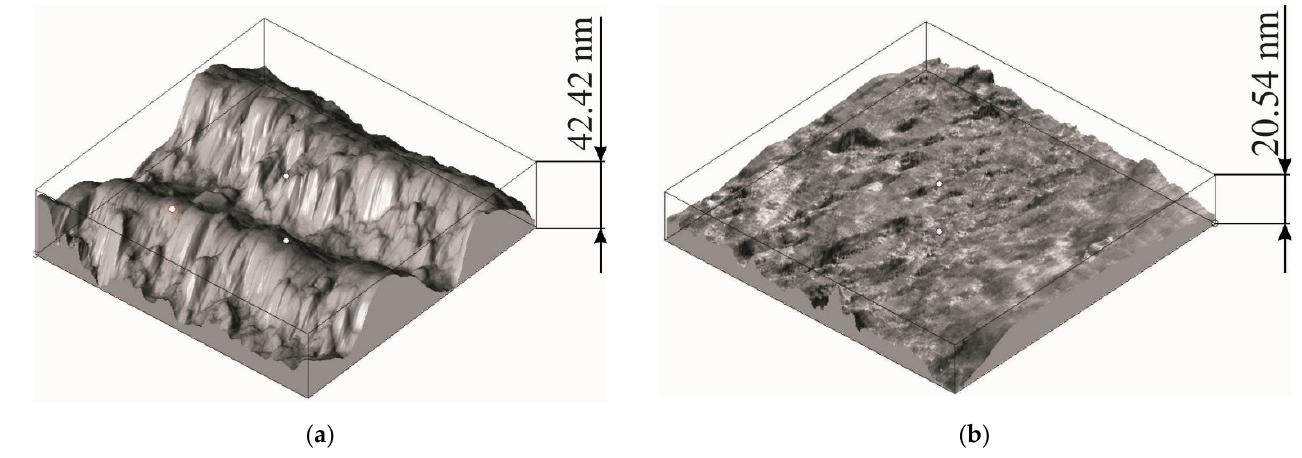
Figure 11. Surface topology (atomic force microscopy) of specimens of 40Kh steel: ( a ) before treatment; ( b ) after cavitation treatment.